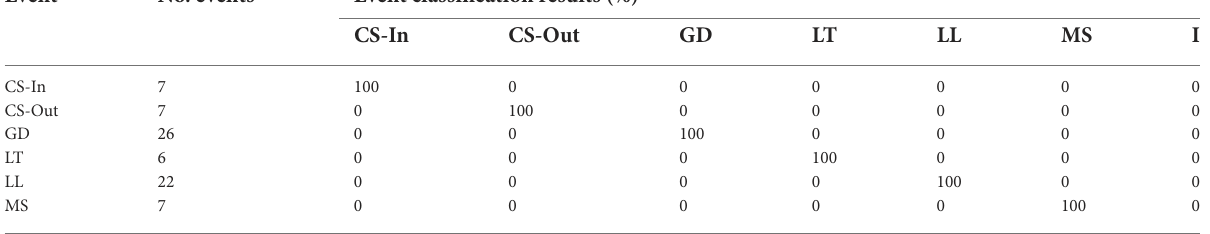
TABLE 3 PSECresultsusing80%ofthedata(322events)fortrainingand20%ofthedata(75events)fortesting. Event